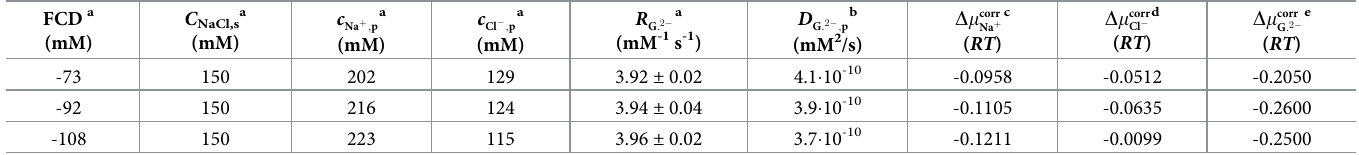
Table 1. Parameter values. Determined values for the different sets of